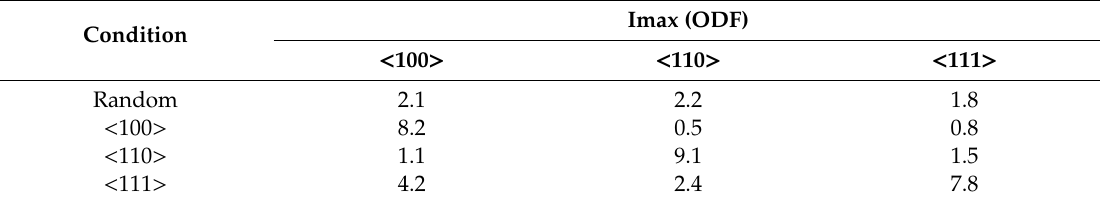
Table 2. Main texture components for the four di ff erent microstructures resulting from specific thermomechanical routes